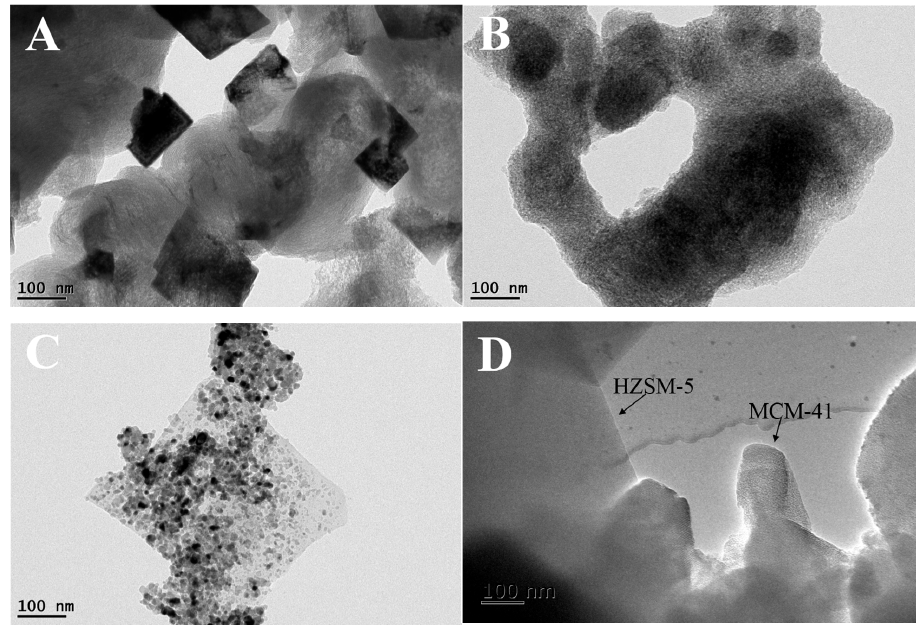
Figure 2. The TEM pictures of the synthesized samples (20 wt % Ni loading): ( A ) Ni/M 0EG; ( B ) Ni/M 1EG; ( C ) Ni/H 1EG; and ( D ) Ni/M(H) 1EG.